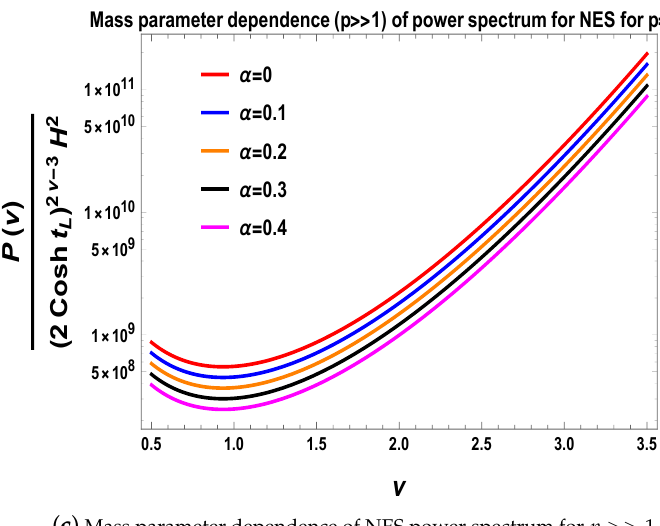
Figure 12. Features of NES power spectrum in large wave number region. ( a ) Large wave number dependence of NES power spectrum for α = 0; ( b ) Large wave number dependence of NES power spectrum for α = 0.1; ( c ) Mass parameter dependence of NES power spectrum for p >>